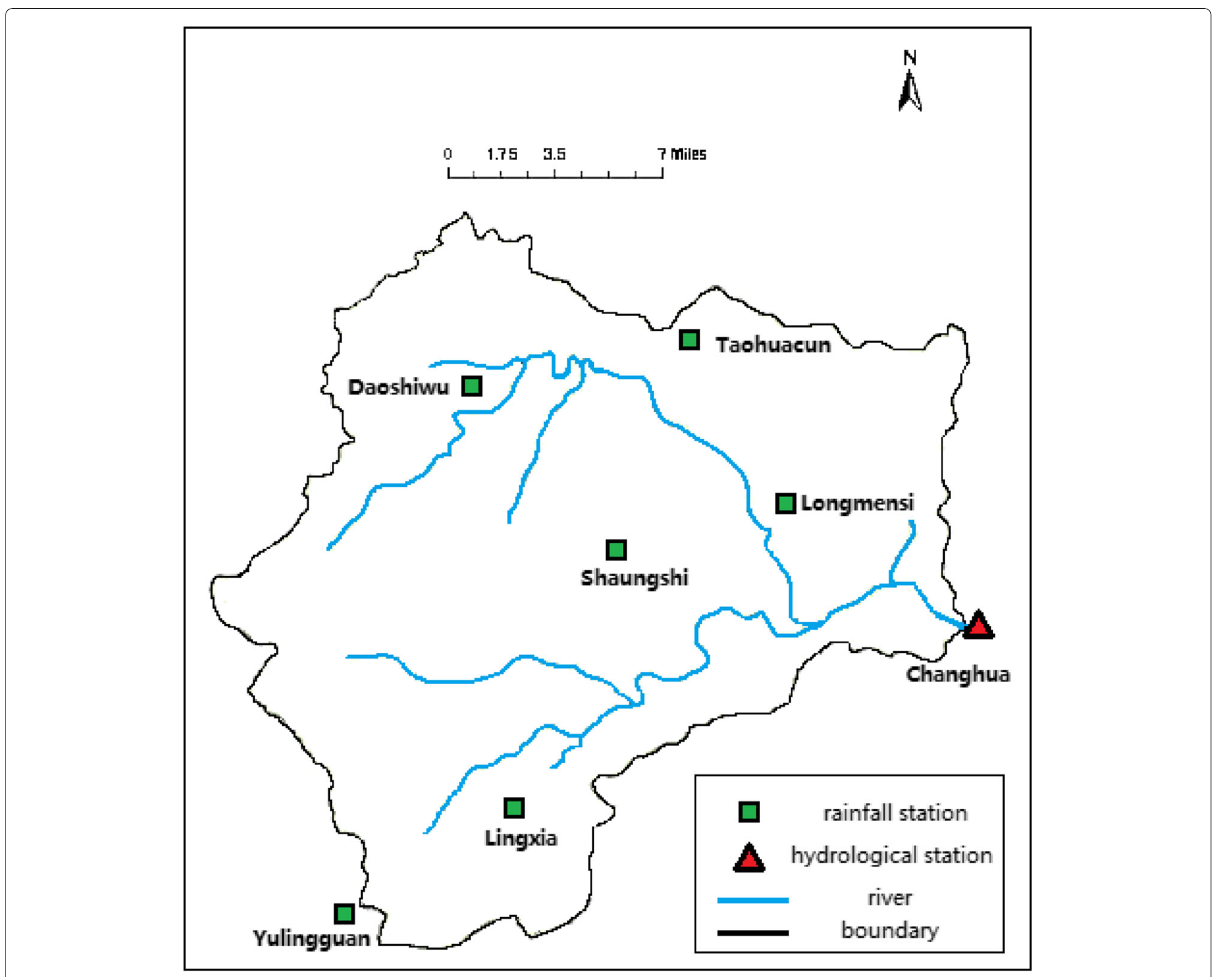
Fig. 3 Map of the Changhua watershed with various kinds of stations. Detailed legend: The sketch map of study area is presented in Fig. 3 and the prediction is performed based on the 1998–2010 historical daily flow rates of 1 gaging station (SS), rainfall values of 7 rainfall stations (including DSW, THC, LMS, SS, LX, YLG, and CH), and evaporation values of 1 evaporation station (SS) in Changhua watershed, a watershed in Xinanjiang River basin in